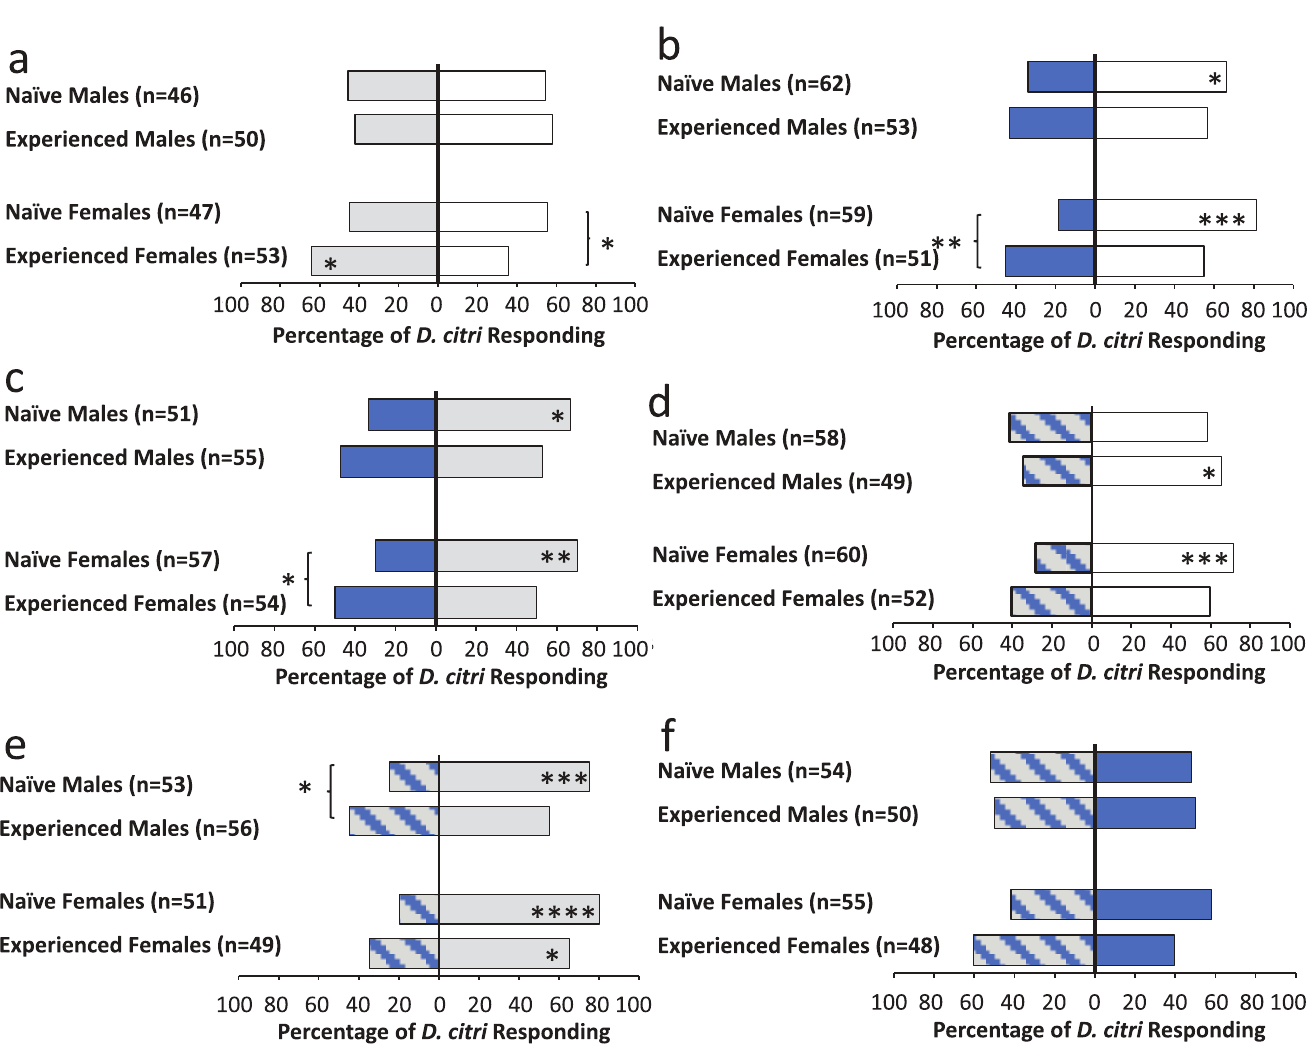
Fig 5. D . citri responses after compound conditioning to six test conditions (a-f). Gray bars represent the olfactory stimulus (vanillin odor), blue bars represent the visual stimulus (blue light), striped blue and gray bars represent the compound stimulus (vanillin odor + blue light), and white bars indicated a blank control. Asterisks ( * ) within the bars indicate statistically significant differences within a group selecting arm A or arm B ( χ 2 test, * : < 0.05, ** : < 0.01, *** : < 0.001), **** : < 0.0001. Asterisks ( * ) outside the bars indicate differences between a set of na ï ve and experienced insects for a given test condition ( χ 2